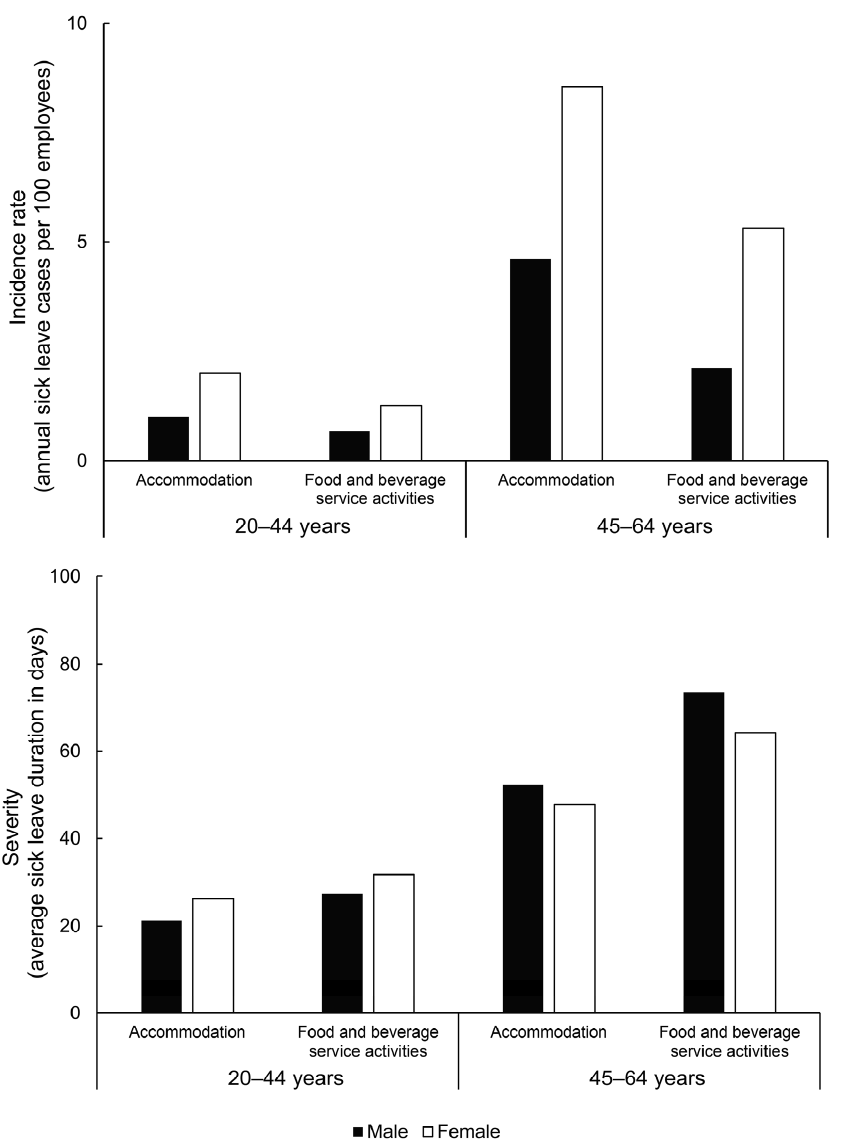
Figure 3. Sick leave determinants due to musculoskeletal disorders per divisions of sector I.